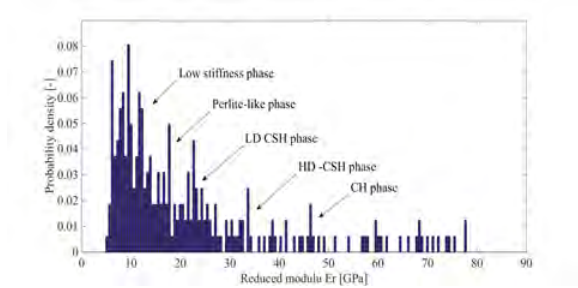
Figure 7. ModCem 0.10 – Reduced modulus his-